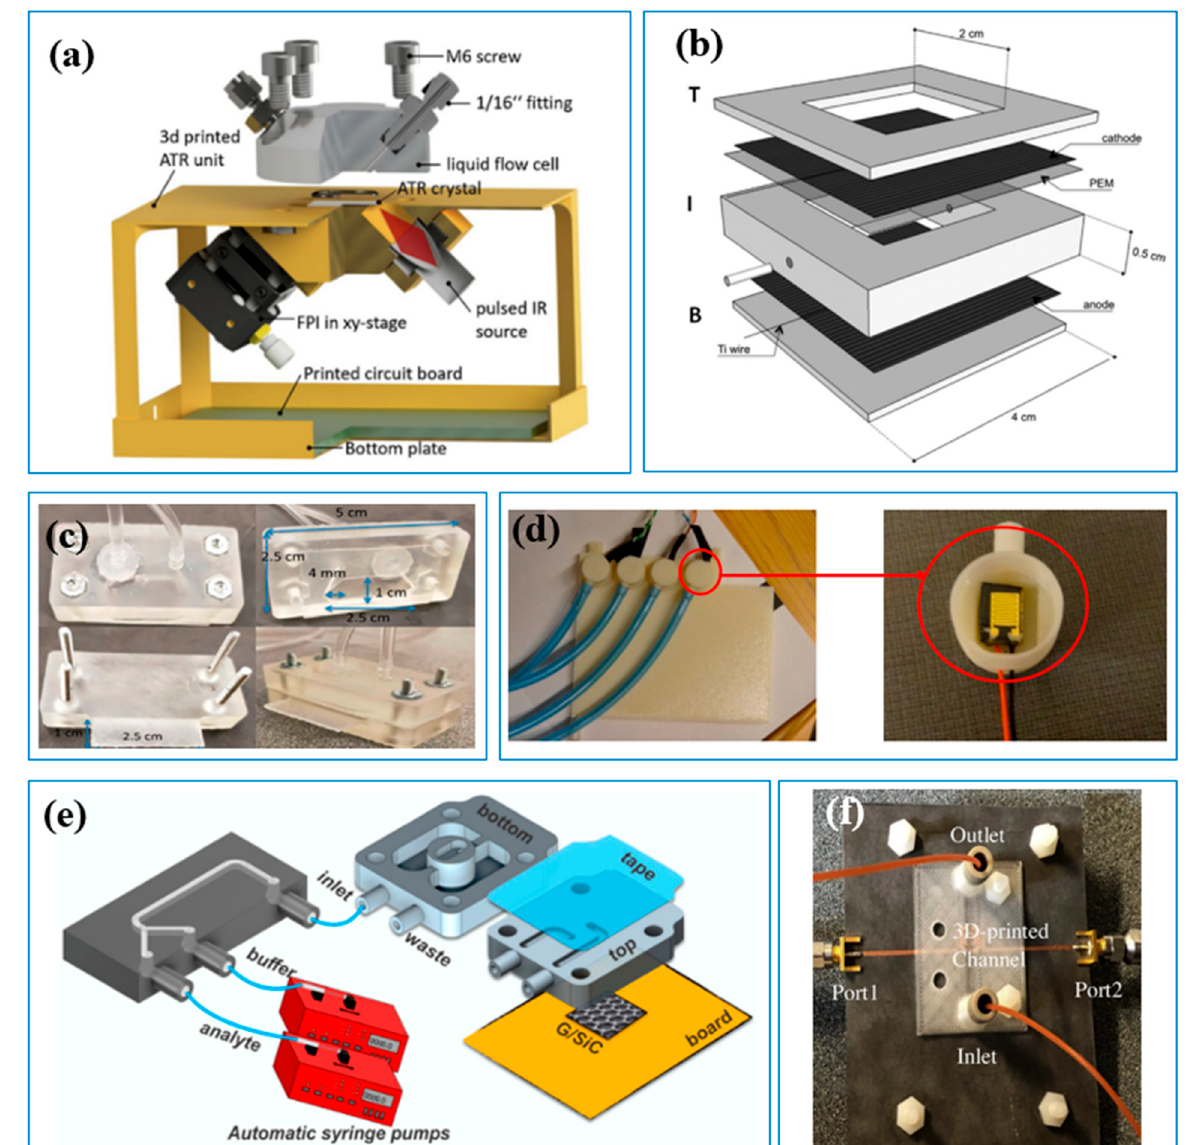
Figure 5. Three-dimensional-printed cells to improve sensors’ performance. ( a ) Three-dimensional- printed mini-spectrometer [42]; ( b ) Layer-by-layer 3D-printed miniature microbial fuel cell [63]. ( c ) Three-dimensional-printed flow cell [18]; ( d ) Three-dimensional-printed interface (right) and a pH sensor fitted into the interface (left) [11]; ( e ) Schematic of the sensing platform [49]; ( f ) Three-dimensional-printed microfluidic channel [50].